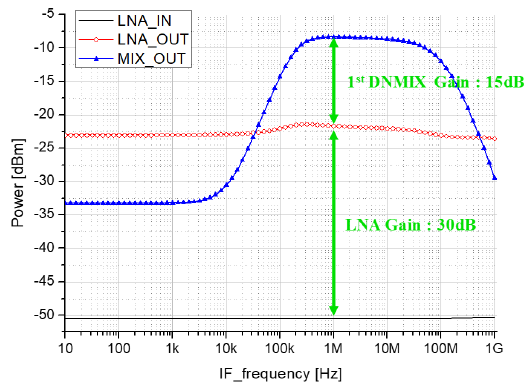
Figure 21. Front-end gain simulation result.